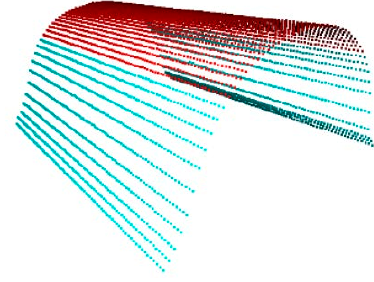
Figure 10. Region of Interest Curve.